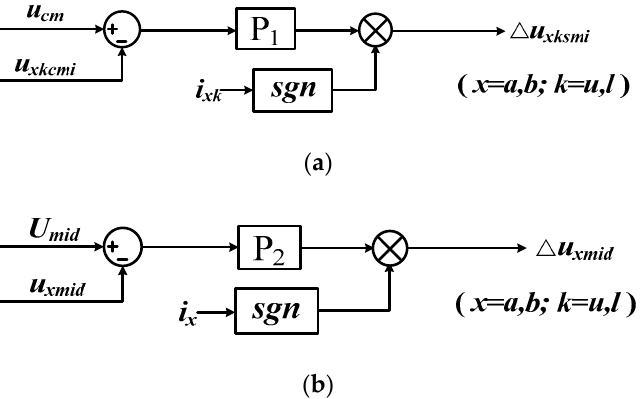
Figure 6. Individual balancing control of SM capacitor voltage. ( a ) The balancing control of the HBSM capacitor voltage. ( b ) The balancing control of the middle cell capacitor voltage.